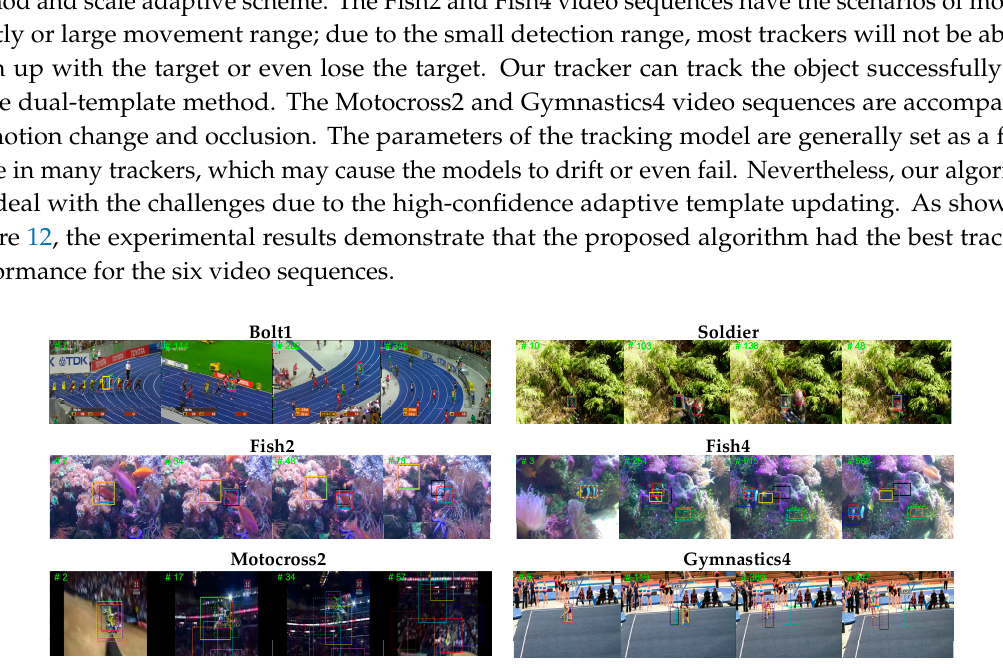
Table 4. Accuracy evaluation of ours and seven other state ‐ of ‐ the ‐ art trackers on different challenging attributes of the VOT 2016 benchmark database. The best two results are marked in red and blue bold fonts, respectively.